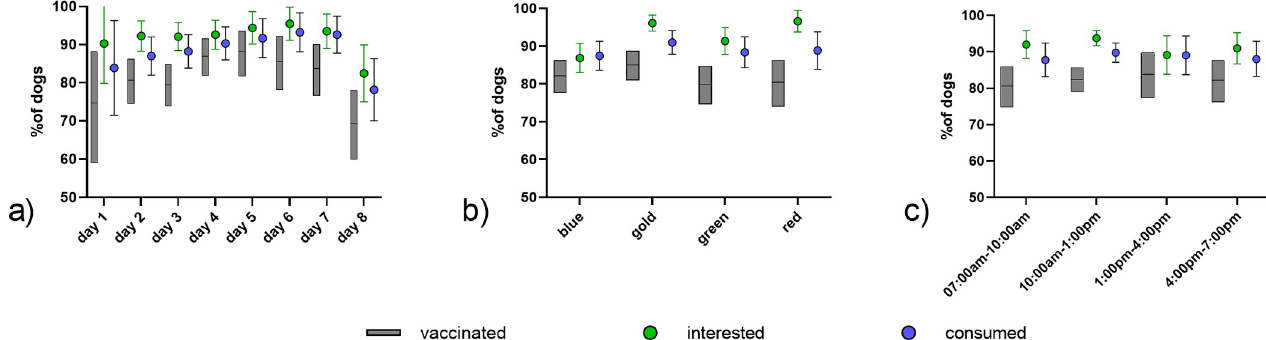
Fig 4. Comparison of bait interest, bait consumption and vaccination per study day (a), daytime (b), and team (c). The mean and the 95% confidence limits are indicated.